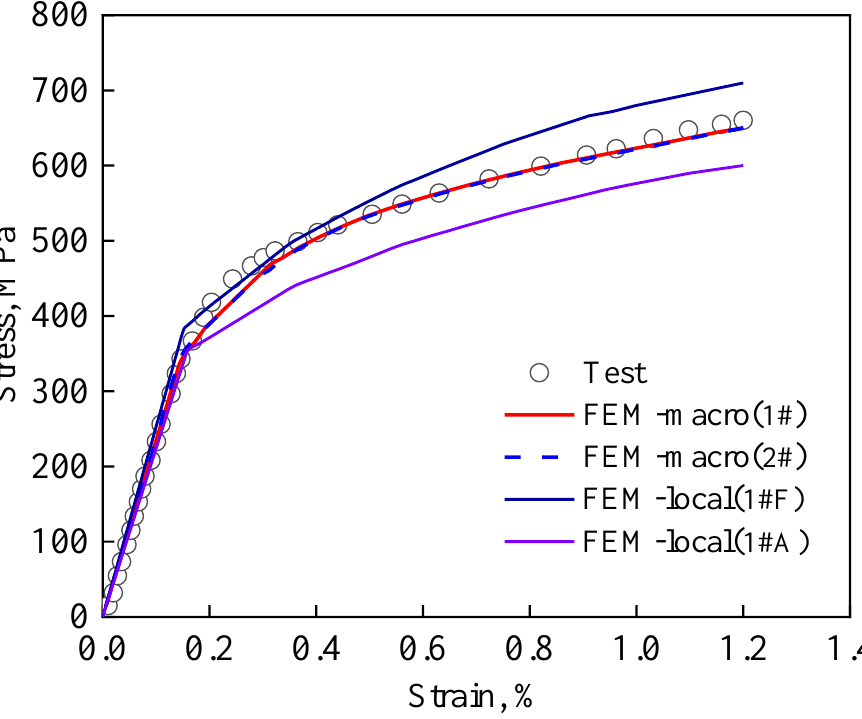
Figure 11. Comparison of tensile curves between experimental and simulation results.